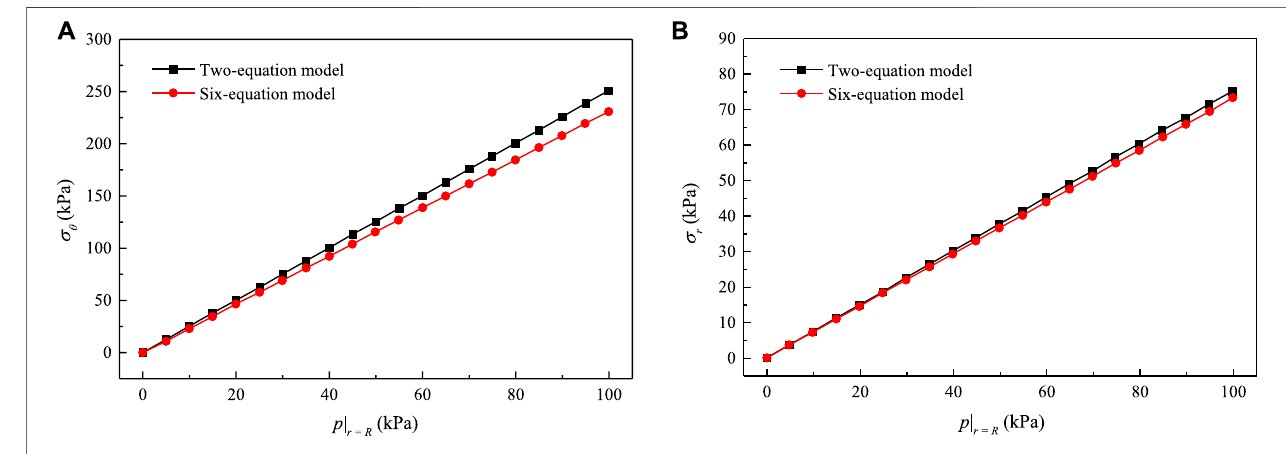
FIGURE 13 | Stress increases with p| r=R (A) Hoop stress. (B) Radial stress.